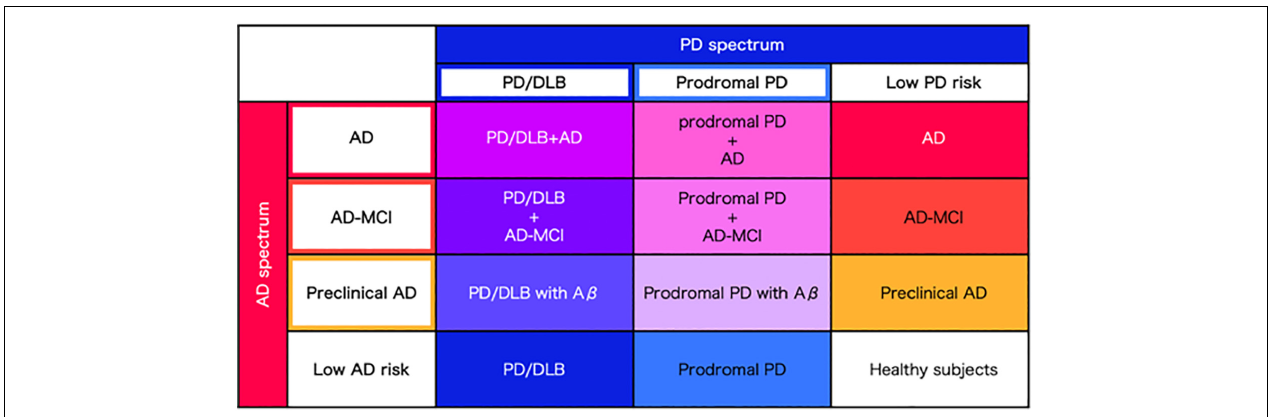
FIGURE 2 | Precise classification of AD and PD spectrum. Regarding AD and PD as spectra, precise disease classification will be performed based on the severity of abnormal protein accumulation and clinical data, derived from each AD and PD